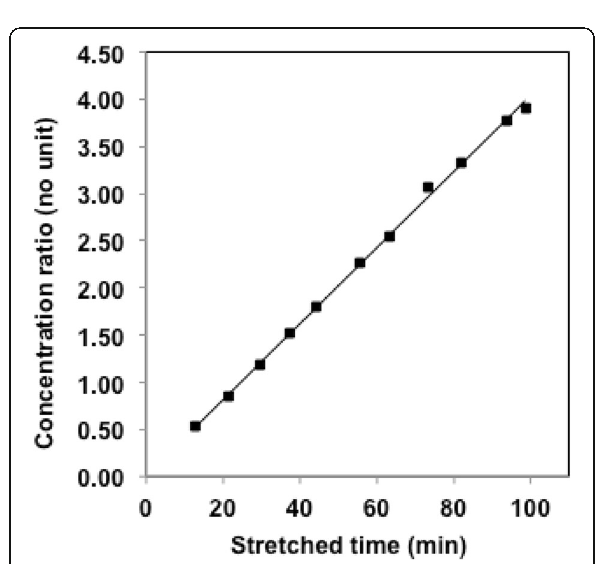
Fig. 2 Patlak ’ s analysis performed in patient 9 (Table 1): y = 0.0403 x + 0.0059 ( R = 0.999; P < 0.001), indicating that the Ki of patient 9 is 0.0403 mL.min -1 .mL -1